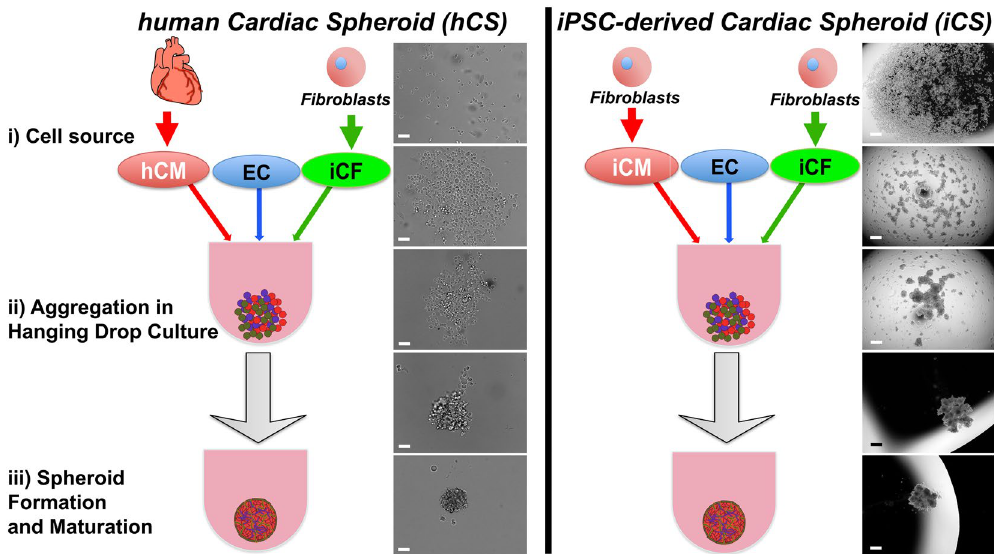
Figure 1. Generation of cardiac spheroids in hanging drop culture. ( a ) Representative bright-field images of human primary cardiomyocytes (hCM), iPS-derived cardiac fibroblasts (iCF) and human coronary artery endothelial cells (ECs) co-cultured in hanging drops for 0, 2, 6, 12 and 24 h. ( b ) Representative bright-field images of hiPS-derived cardiomyocytes (iCM), iCF and ECs in hanging drop co-cultures after 0, 12, 24, 48 and 96 h. Scale bars: 100 μ m. See also Figs S1, S2 and Videos S1 and